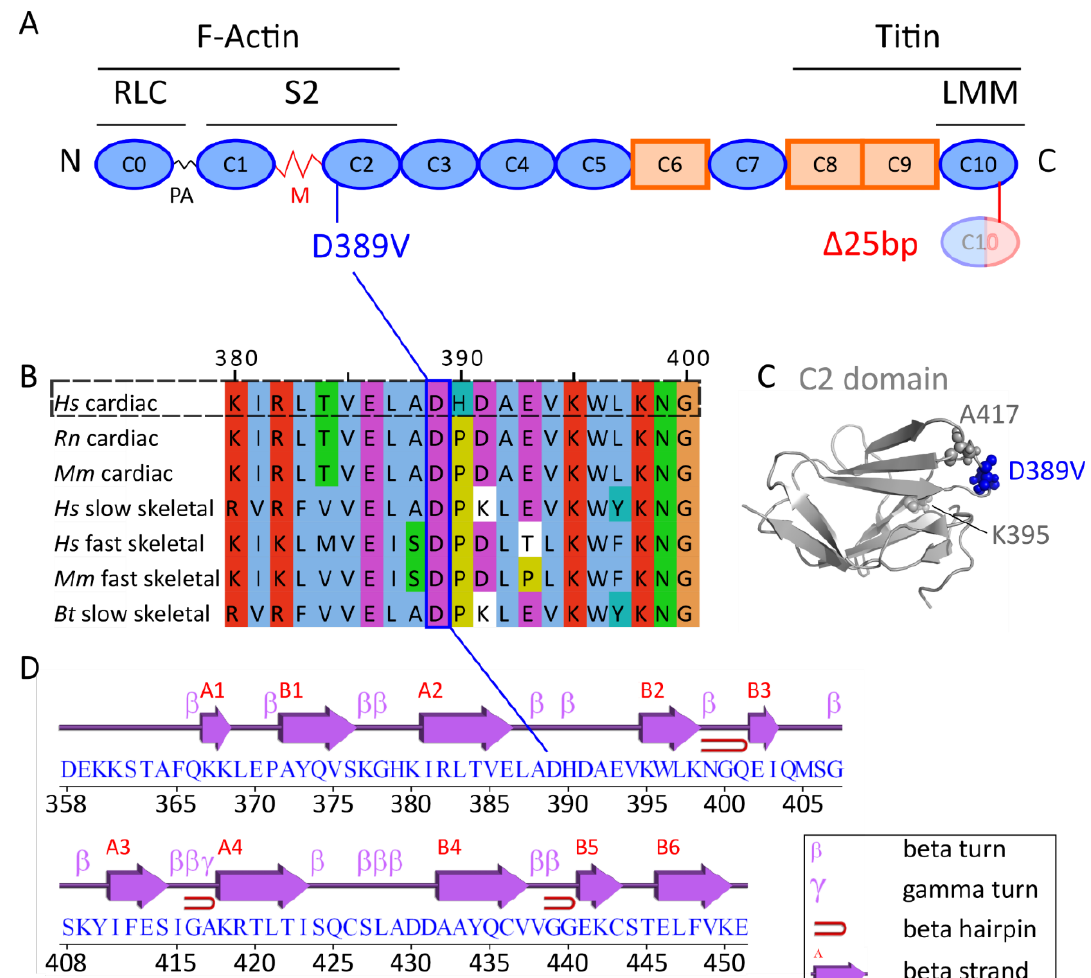
Figure 1. Schematic diagram showing the domain organization of MyBPC and its C2 domain. ( A ) MyBPC consists of eight IgI-like domains (blue), three FnIII-like domains (orange), and one unique M domain. Binding partners are indicated above the respective subdomains. The positions of the MYBPC3 ∆ 25bp/D389V mutation are indicated. PA: proline–alanine-rich region. ( B ) Alignment of MyBPC C2 protein sequences. Residue D389 is highly conserved across different mammalian isoforms. Rn: Rattus norvegicus , Mm: Mus musculus , Hs: Homo sapiens , Bt: Bos taurus . Alignment was created using T-Coffee [29] and Jalview [30]. ( C ) Cartoon representation of the MyBPC C2 domain (PDB: 5k6p [31]) with relevant residues D389, K395, and A417 displayed as spheres. ( D ) Domain topology scheme of the C2 domain as generated by EMBL-EBI PDBsum (https://bio.tools/pdbsum_generate; last accessed on 3 November 2021). A1–A4 and B1–B6 represent strands of the β-sheets A and B.